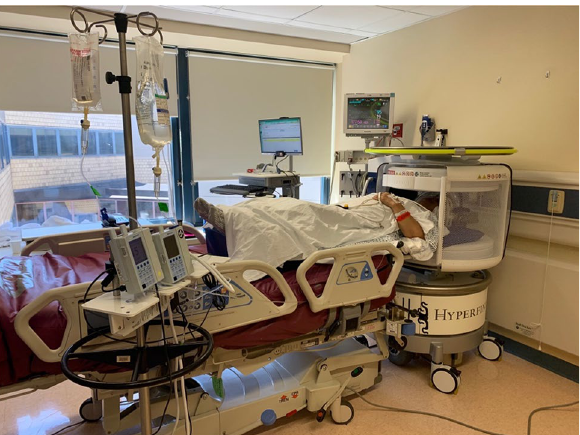
Figure 1. 0.064 T Portable MRI scanner in an intensive care unit room. Low-field portable MRI exams were performed in the presence of operational intensive care equipment. The portable MRI operator and bedside nurse were able to remain in the room during scanning. All portable MRI images were available for real-time viewing on an iPad as each sequence was acquired and